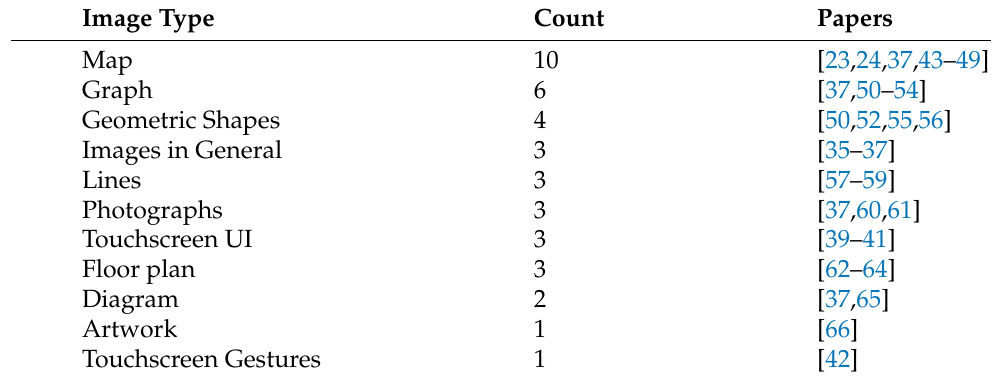
Table 1. Types of supported images for people who are blind or have low vision